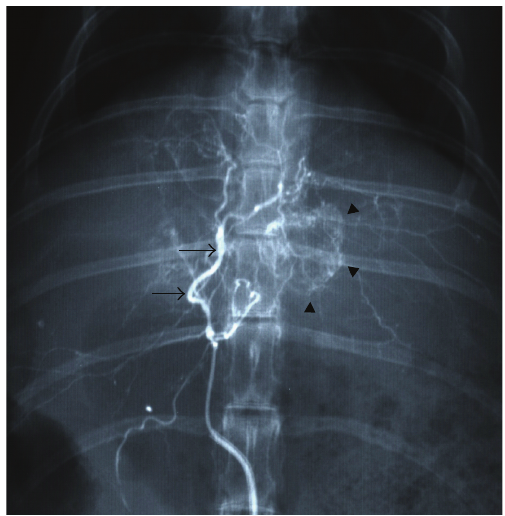
Figure 1: TACE procedure. The therapeutic agent was administered via a 2.3-Fr microcatheter inserted into the middle hepatic artery (arrows), which can be seen feeding the tumor